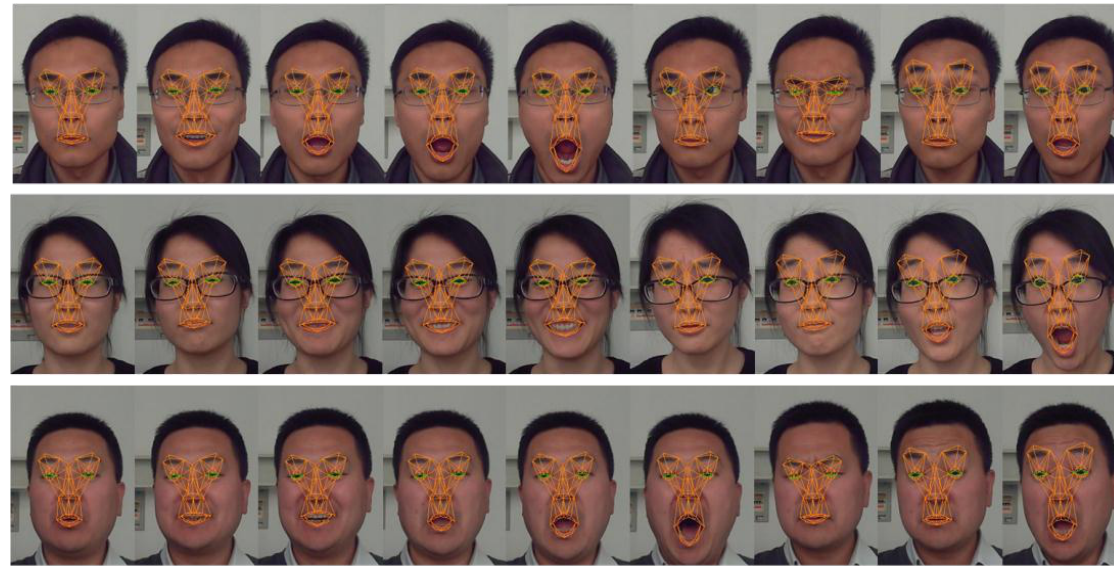
Figure 12. Tracked images of different persons in the laboratory.